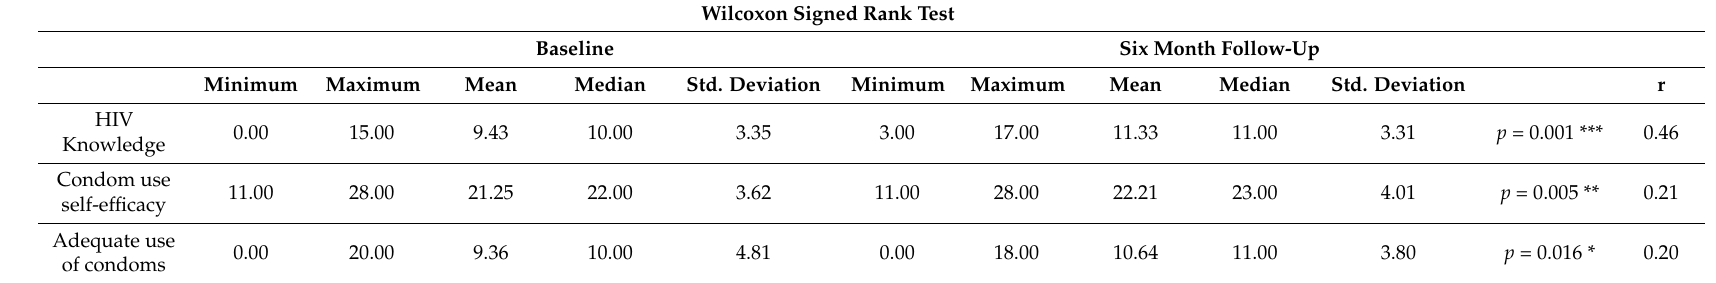
Table 4. Related samples Wilcoxon signed rank test of changes in hiv knowledge, ability to practice hiv prevention behaviors, and correct use of condoms from baseline to 6-month